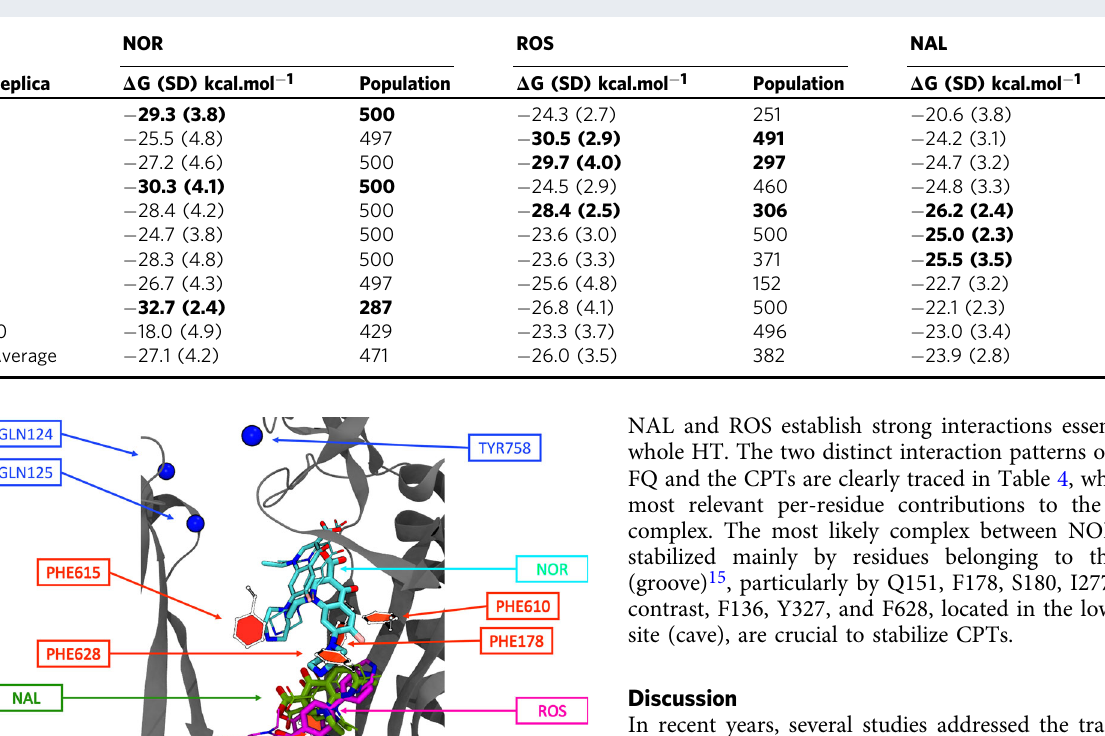
Table 3 Binding free energies of NOR, ROS and NAL. Binding free energies and corresponding standard deviation (within parentheses) calculated on the most populated cluster of each replica. The cluster population is also reported. Representative clusters reported in boldface are shown in Fig. 7.